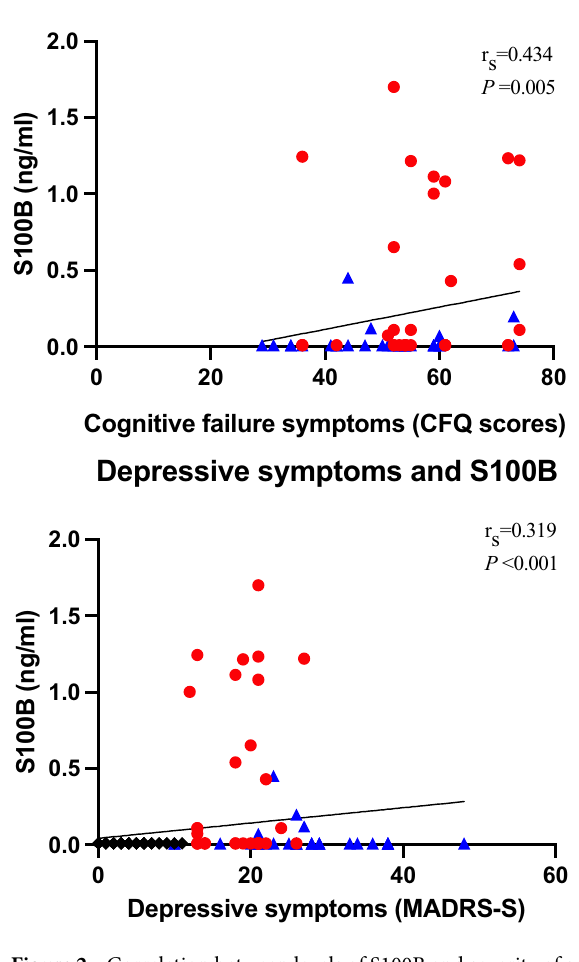
Figure 2. Correlation between levels of S100B and severity of self-rated symptoms of cognitive failure measured with the Cognitive Failure Questionnaire (CFQ) and severity of self-rated depressive symptoms measured with the self-assessment version of the Montgomery Åsberg Depression Rating Scale (MADRS-S) . Red filled circle = patients with stress-induced exhaustion disorder; Blue filled triangle = patients with major depressive disorder and black filled diamond = healthy